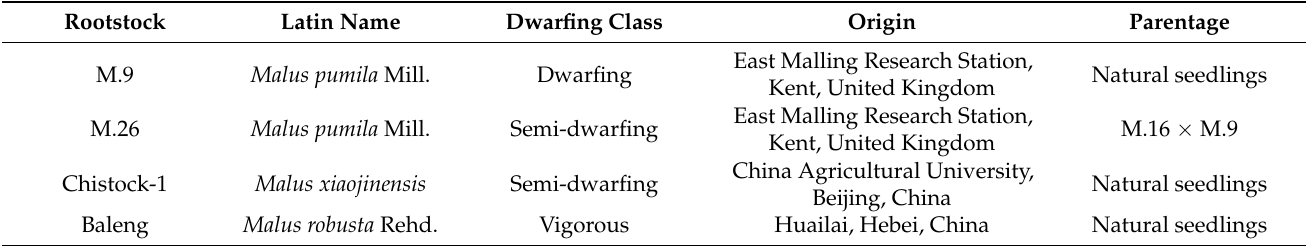
Table 1. Basic information of apple rootstocks in this